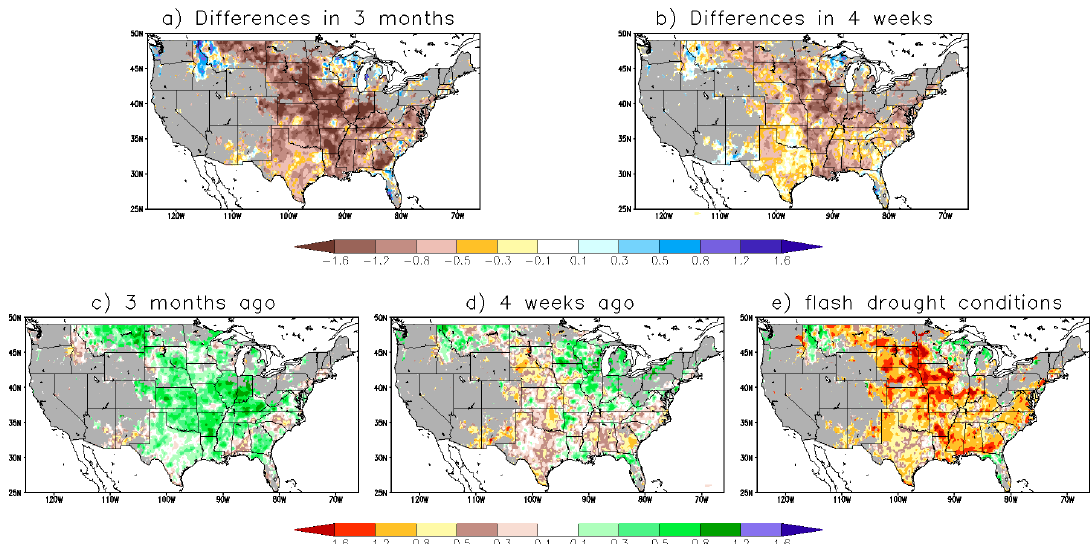
Figure 9. Composites of seven-day Standardized Evapotranspiration Index for ( a ) differences between flash drought conditions and the conditions three months ago, ( b ) differences between flash drought conditions and the conditions four weeks ago, ( c ) the conditions three months before drought onset, ( d ) the conditions four weeks before drought onset, and ( e ) the conditions under flash drought onset. Areas with less than 1% flash drought occurrence are shown in grey.